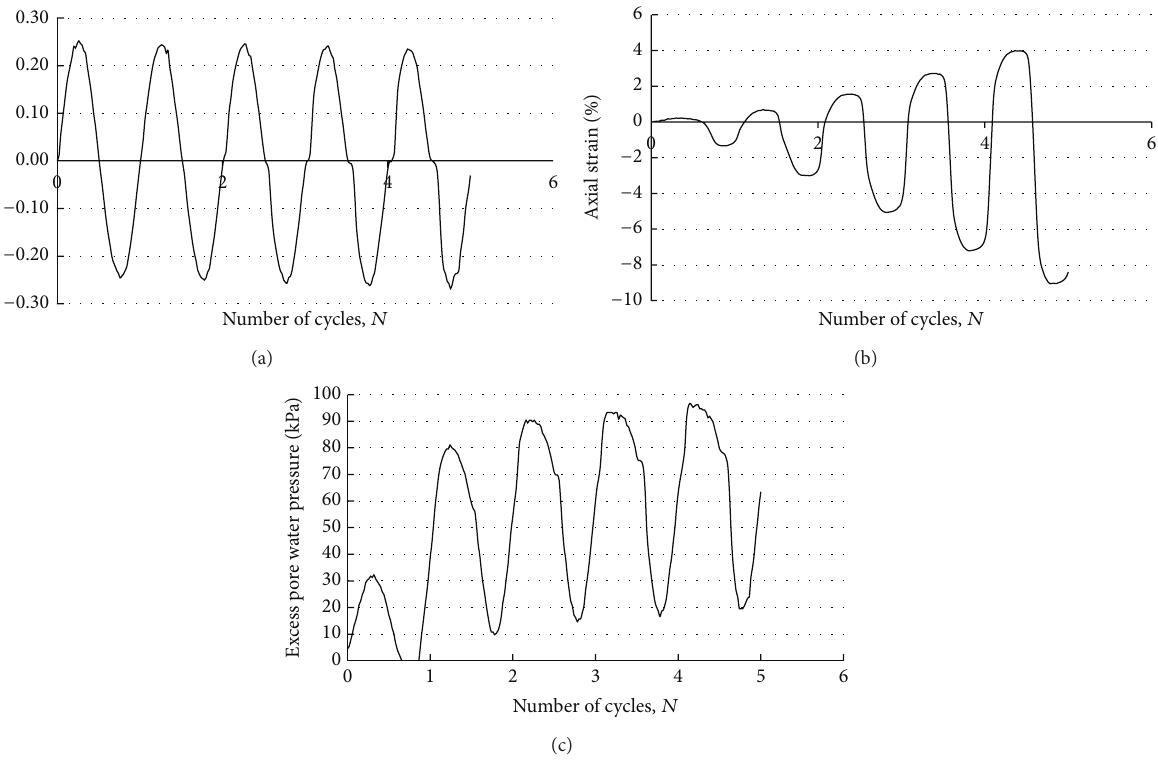
Figure 4: Cyclic triaxial test results of silty soil a having content 54% fine 4% clay for CSR = 0.25